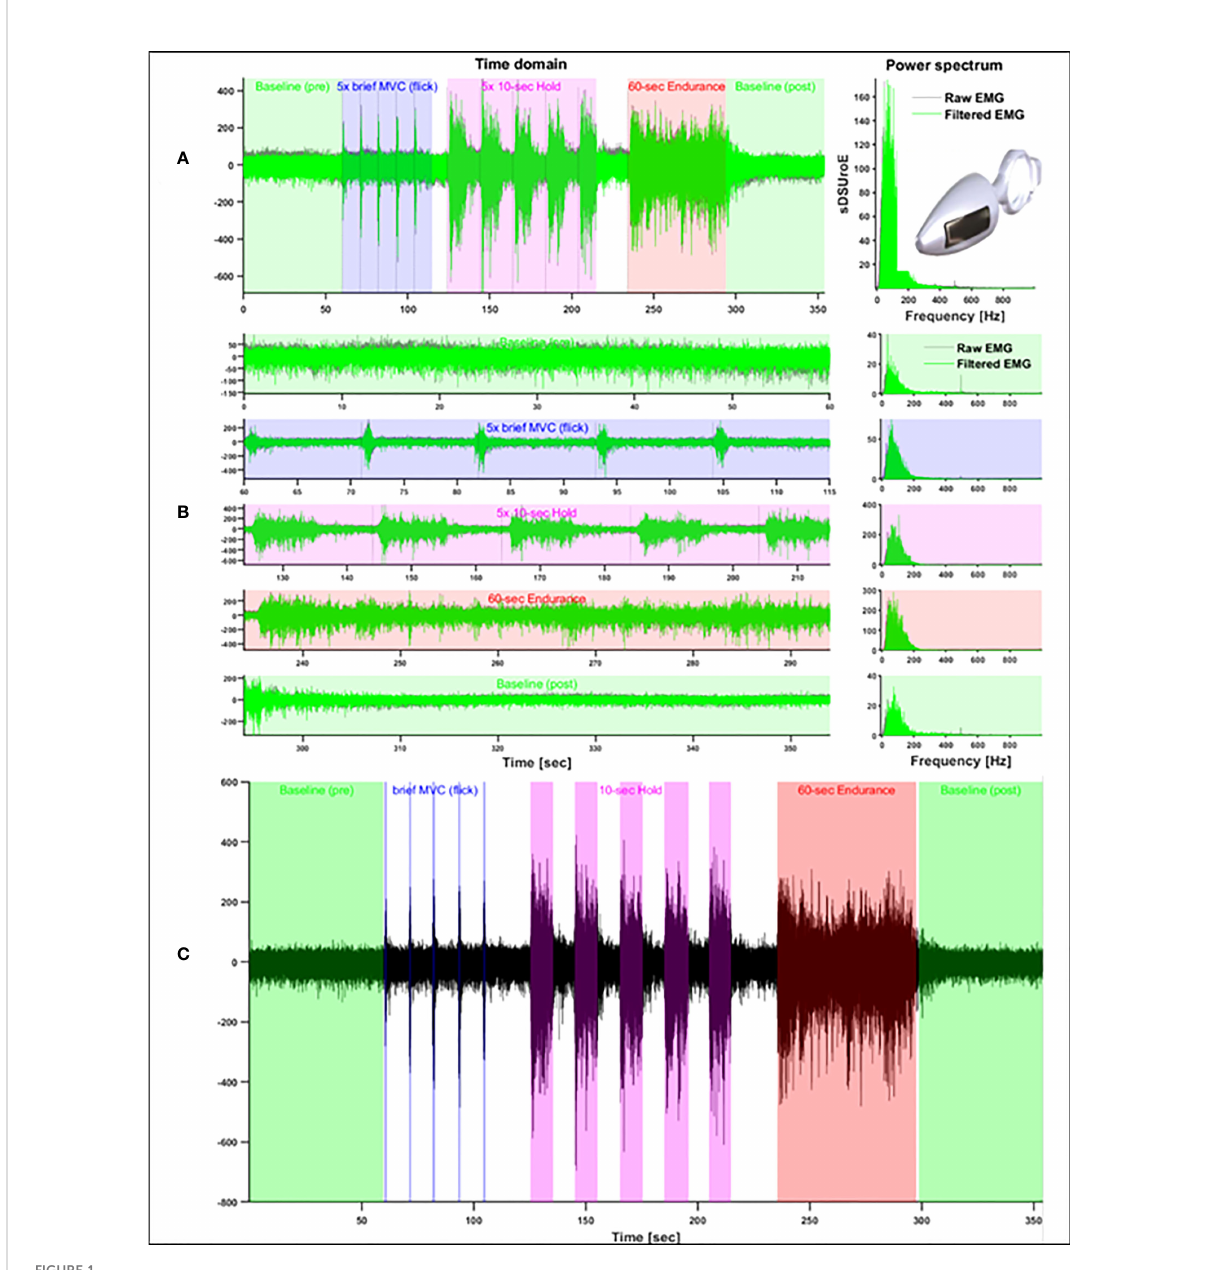
FIGURE 1 Glazer Protocol plots showing full signal and intravaginal probe image (A) , protocol segment tasks (B) and contraction time window with all performed tasks (C)